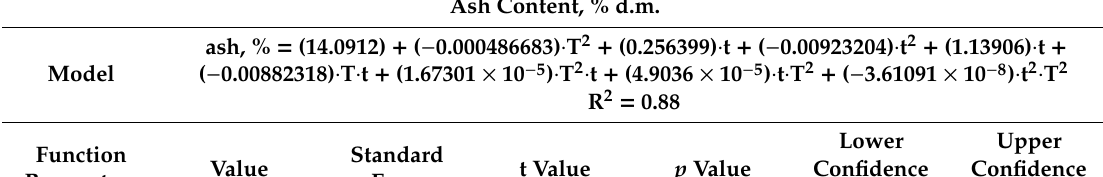
Table A4. The statistical parameters of polynomial regression analysis of the influence of SS torrefaction temperature and residence time on ash content in biochars.